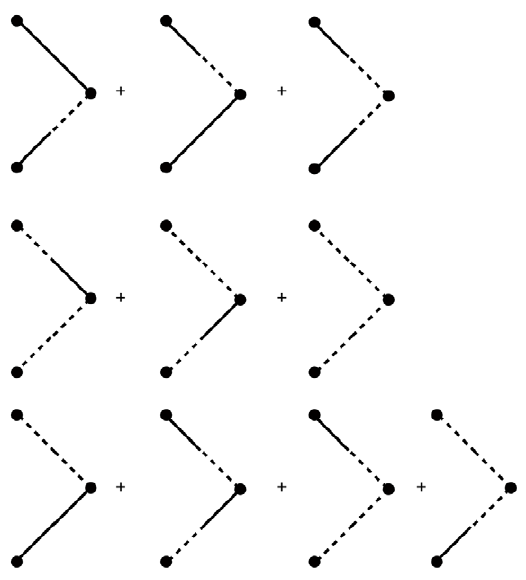
Figure 5. Feynman diagrams for the connected two point correlation functions in the neural field models. By row they are S d u ( t ) d u ( t ’ ) T , S y ( h , c , t ) y ( h , c , t ) T , and S d u ( t ) y ( h , c , t ) T .